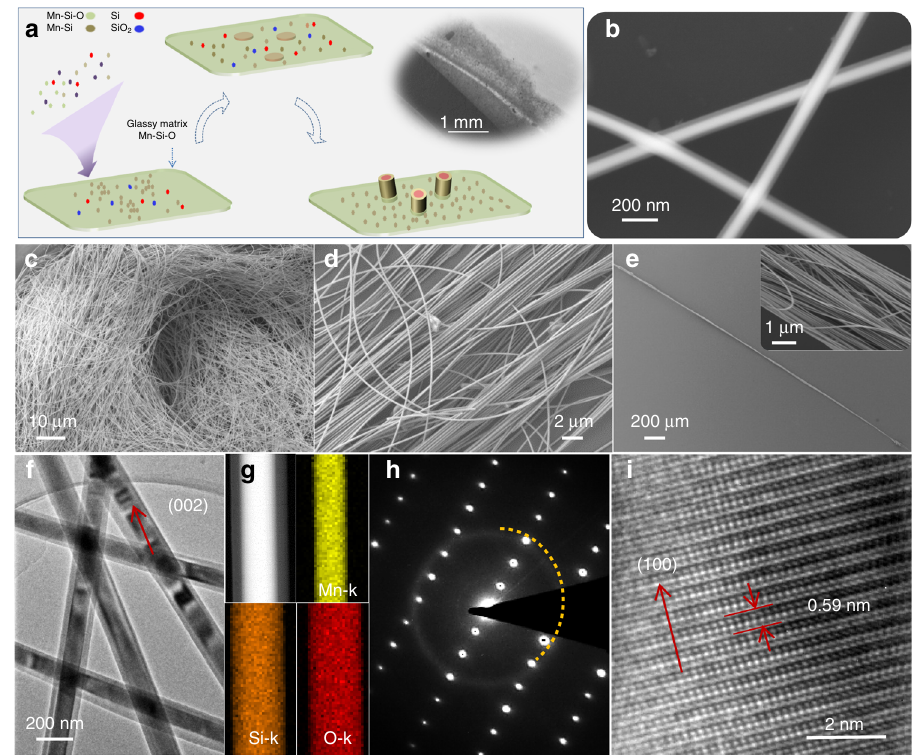
Fig. 1 Growth illustration and characterization of Mn 5 Si 3 @SiO 2 nanocables. a The growth schematic, inset shows the as-synthesized sample on ceramic sheet. b SEM observation of several core – shell nanowires. c – d Nanowire piles after being transferred to Si substrate. e A nanowire bundle composed of many quasi-orientated unites, inset shows the closer view. f Typical bright fi eld TEM image of several core – shell nanowires. g The STEM-EDS mapping characterization of a piece of nanowire, which includes Mn, Si and O elements. h The SAED pattern of the nanowire, dash semi-circle denotes the signal corresponding to amorphous SiO 2 sheath. i HRTEM image highlighting the nanowire growing along c -axial.